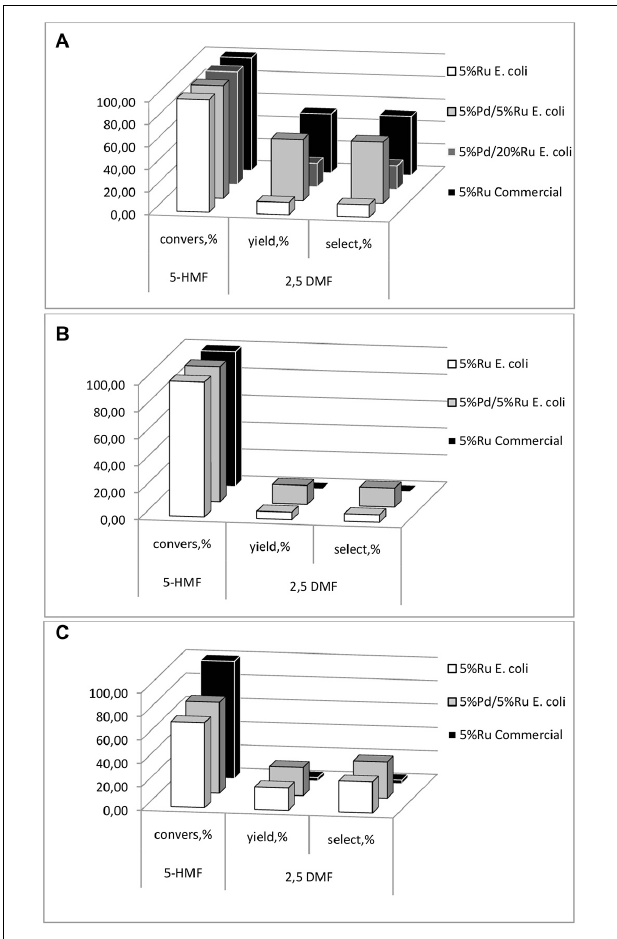
FIGURE 9 | 5-HMF conversion, DMF yield and selectivity to DMF of the catalyst preparations using (A) synthetic 5-HMF (commercial source), (B) starch and (C) cellulose hydrolyzates with 5-HMF extracted into MTHF which was also the solvent for the